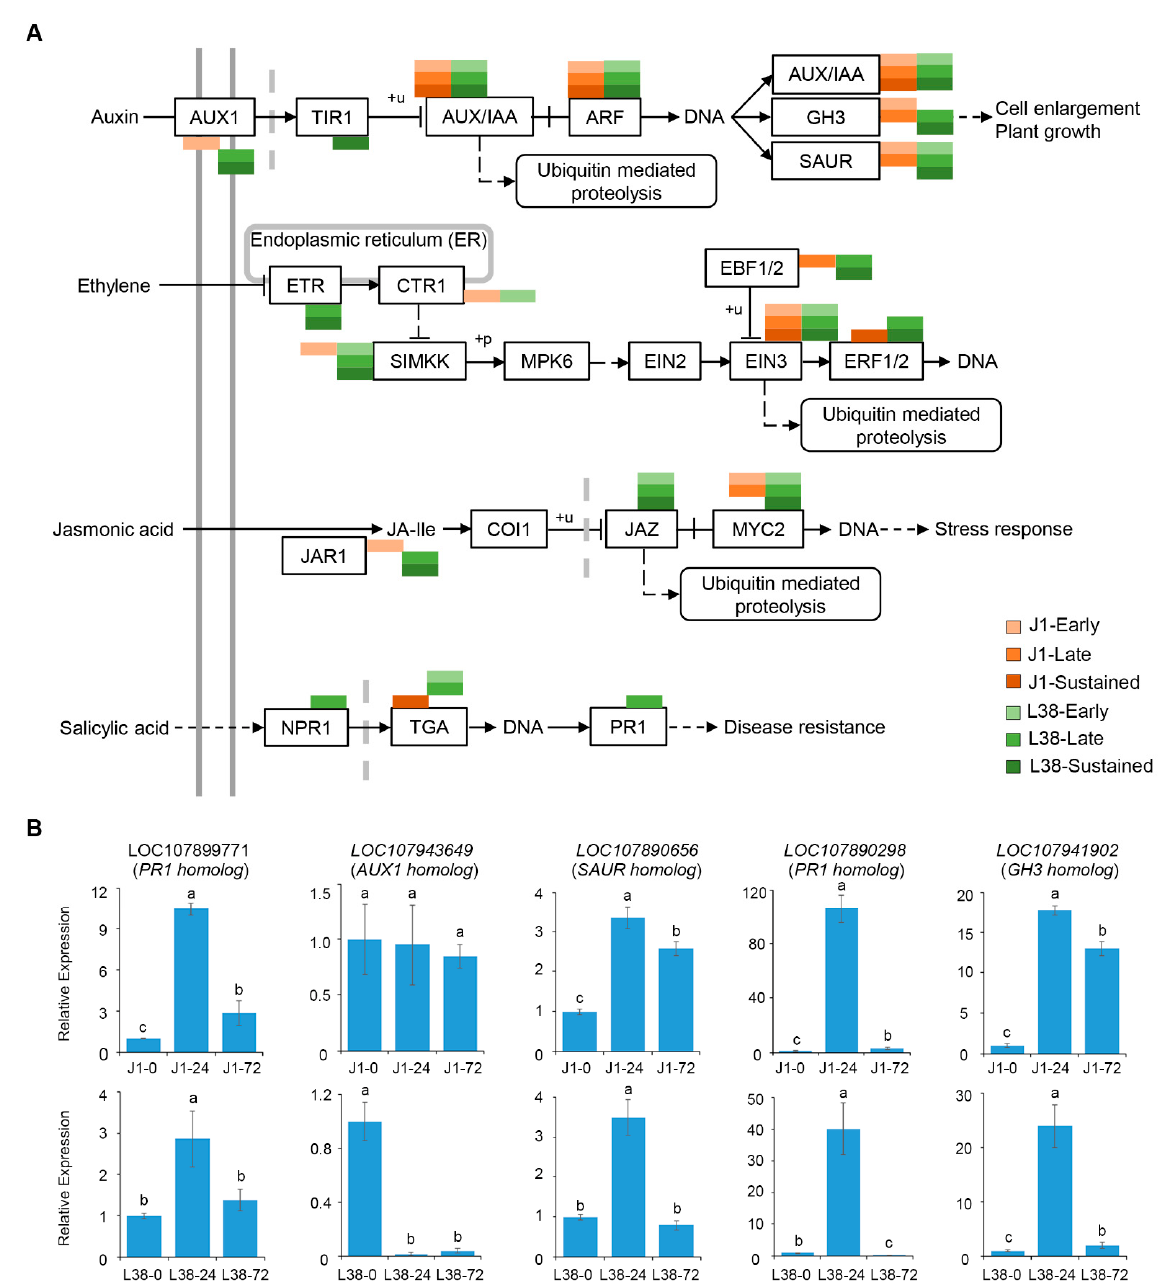
Figure 5. DEGs were enriched in plant hormone signal transduction. ( A ) Demonstration of enrichment of DEGs assigned in plant hormone signal transduction with p -value < 0.05. ( B ) Expression pattern analysis of specific DEGs of J1 and L38 in plant hormone signal transduction by qRT-PCR. Relative expression levels were normalized by cotton 18S expression level. The relative gene expression level in J1-0 and L38-0 were assigned a value of 1. Error bars indicate ± SD of three biological replicates, with each measured in triplicate. Samples marked with different letters show a significant difference at p < 0.05 by Duncan’s multiple range